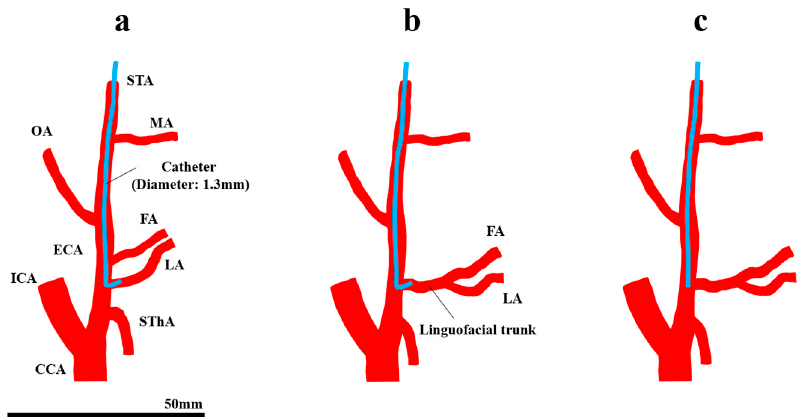
Figure 1. Retrograde intra-arterial chemotherapy for oral cancer. ( a ) Superselective intra-arterial chemotherapy, ( b ) the FA and LA bifurcate from the common trunk, and ( c ) conventional intra-arterial chemotherapy. CCA, common carotid artery; ECA, external carotid artery; FA, facial artery; ICA, internal carotid artery; LA, lingual artery; MA, maxillary artery; OA, occipital artery; STA, superficial temporal artery; SThA, superior thyroid artery.